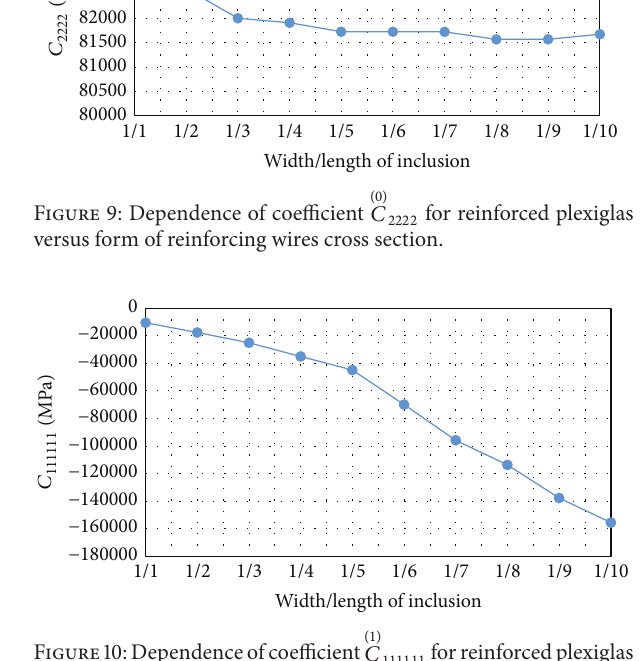
(0) 𝐶 1111 for reinforced plexiglas